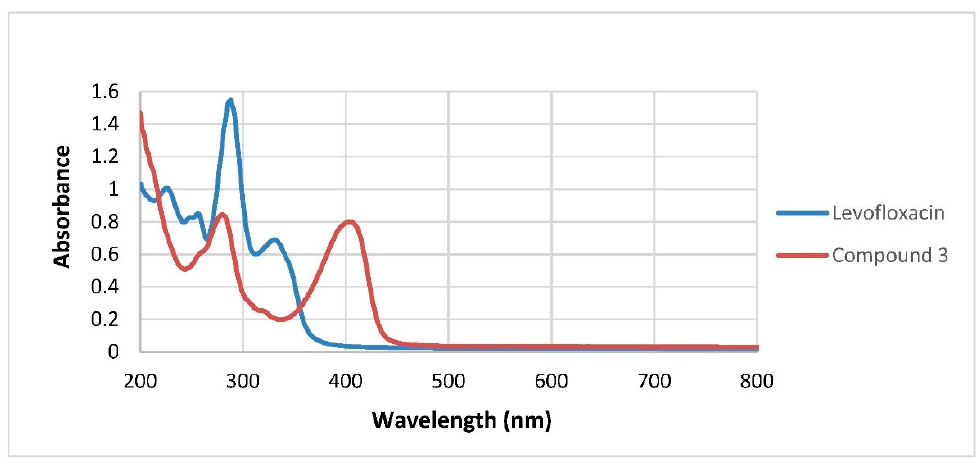
Figure 5. The excitation spectra of both levofloxacin and compound 3 .